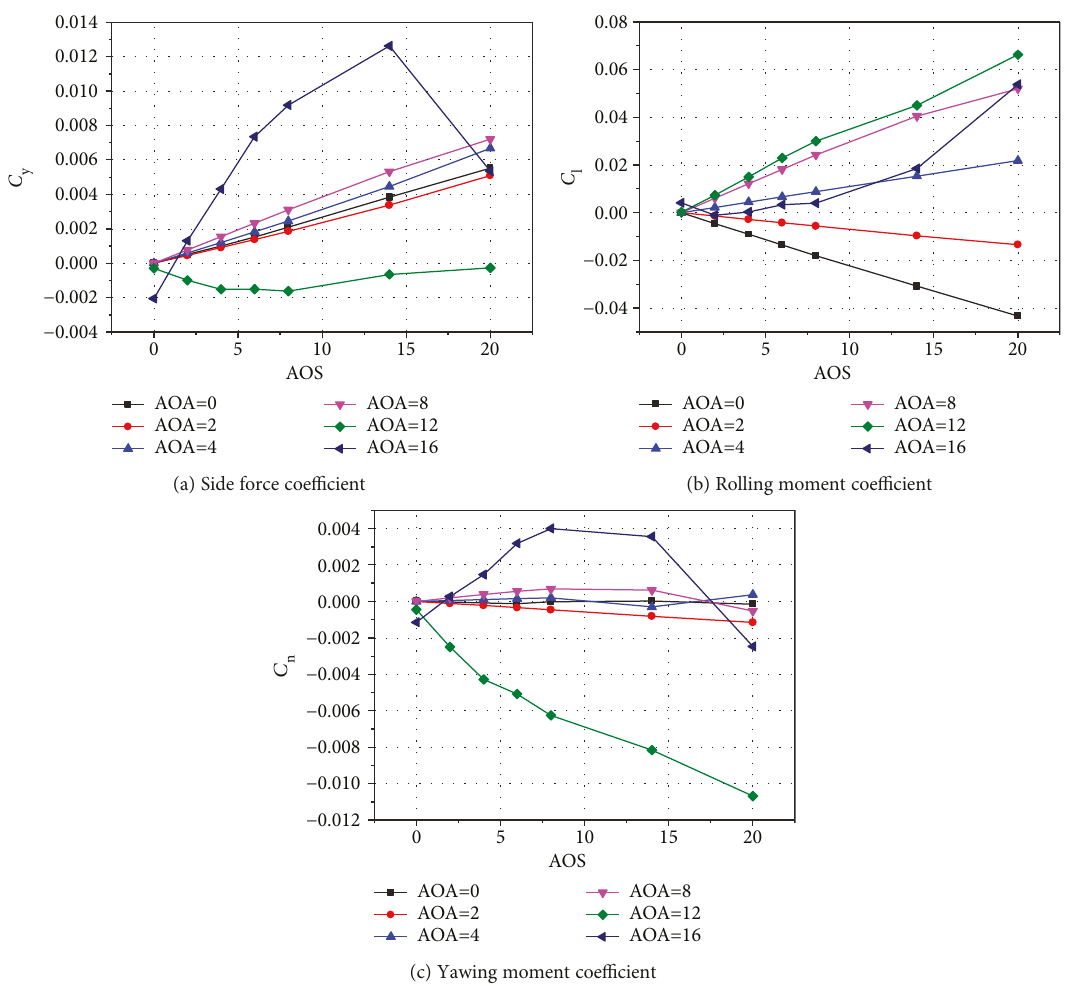
Figure 10: Side force, rolling moment, and yawing moment coe ffi cients for the side slip